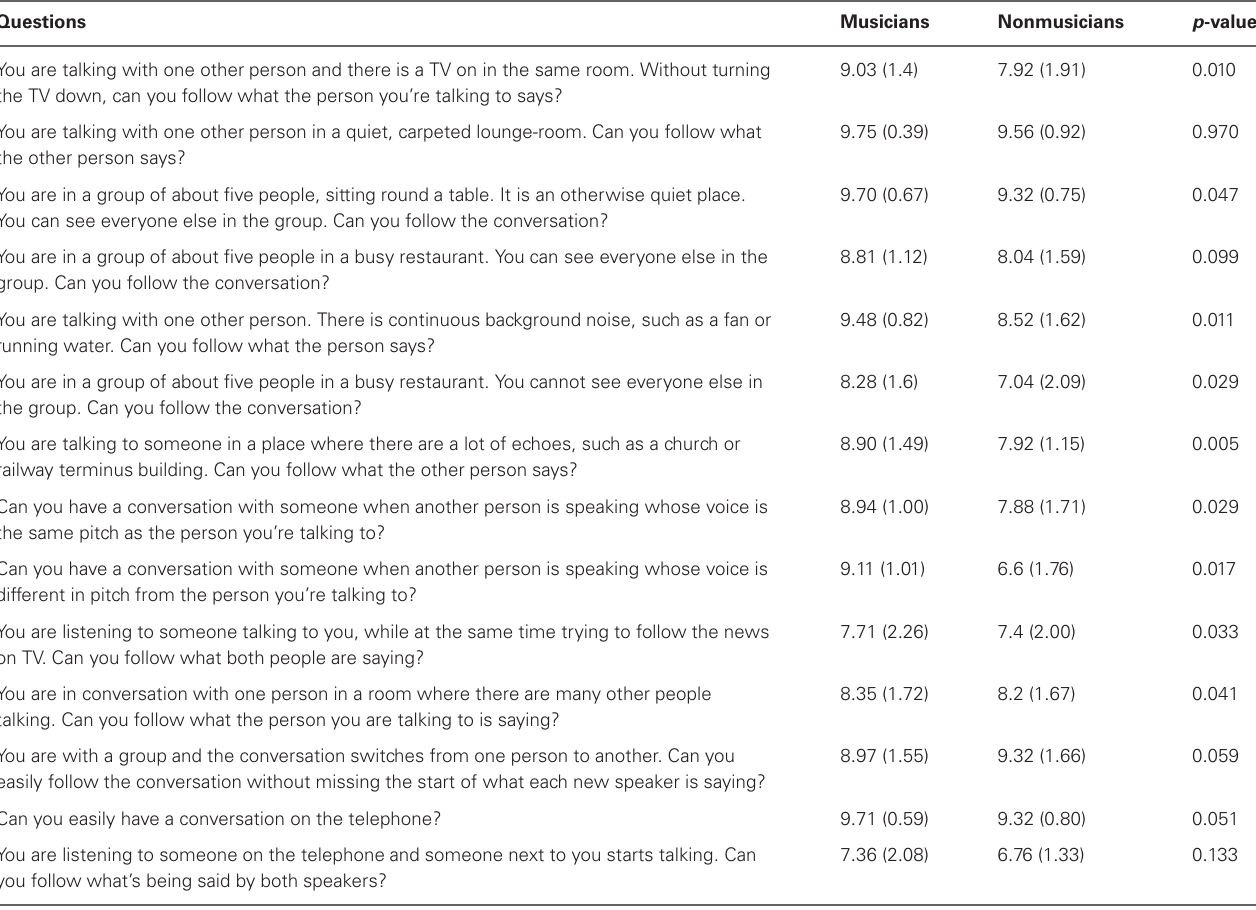
Table 3 | Means, standard deviations, and significance values for the musician and nonmusicians groups’ self-assessment of their speech perception and speech-in-noise